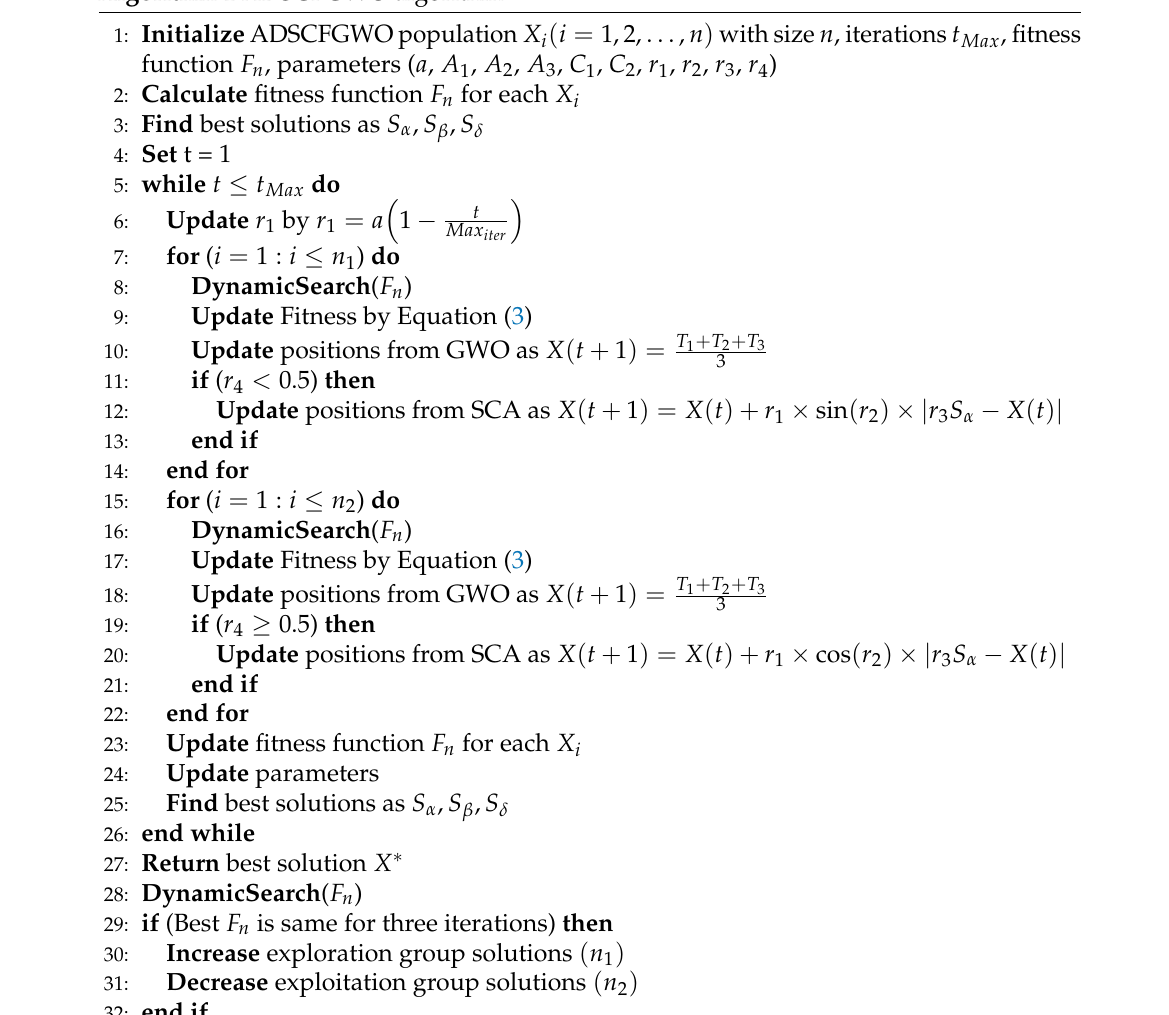
Algorithm 1 ADSCFGWO algorithm